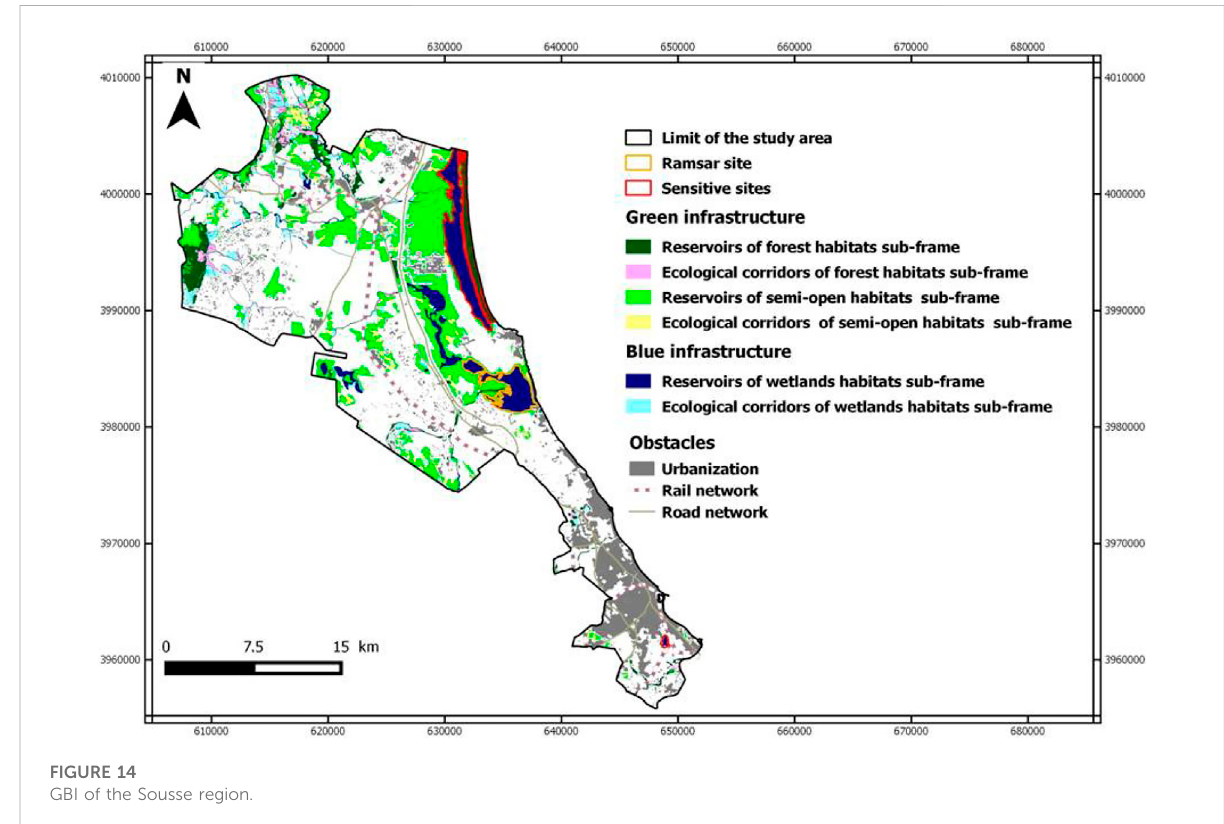
FIGURE 14 GBI of the Sousse